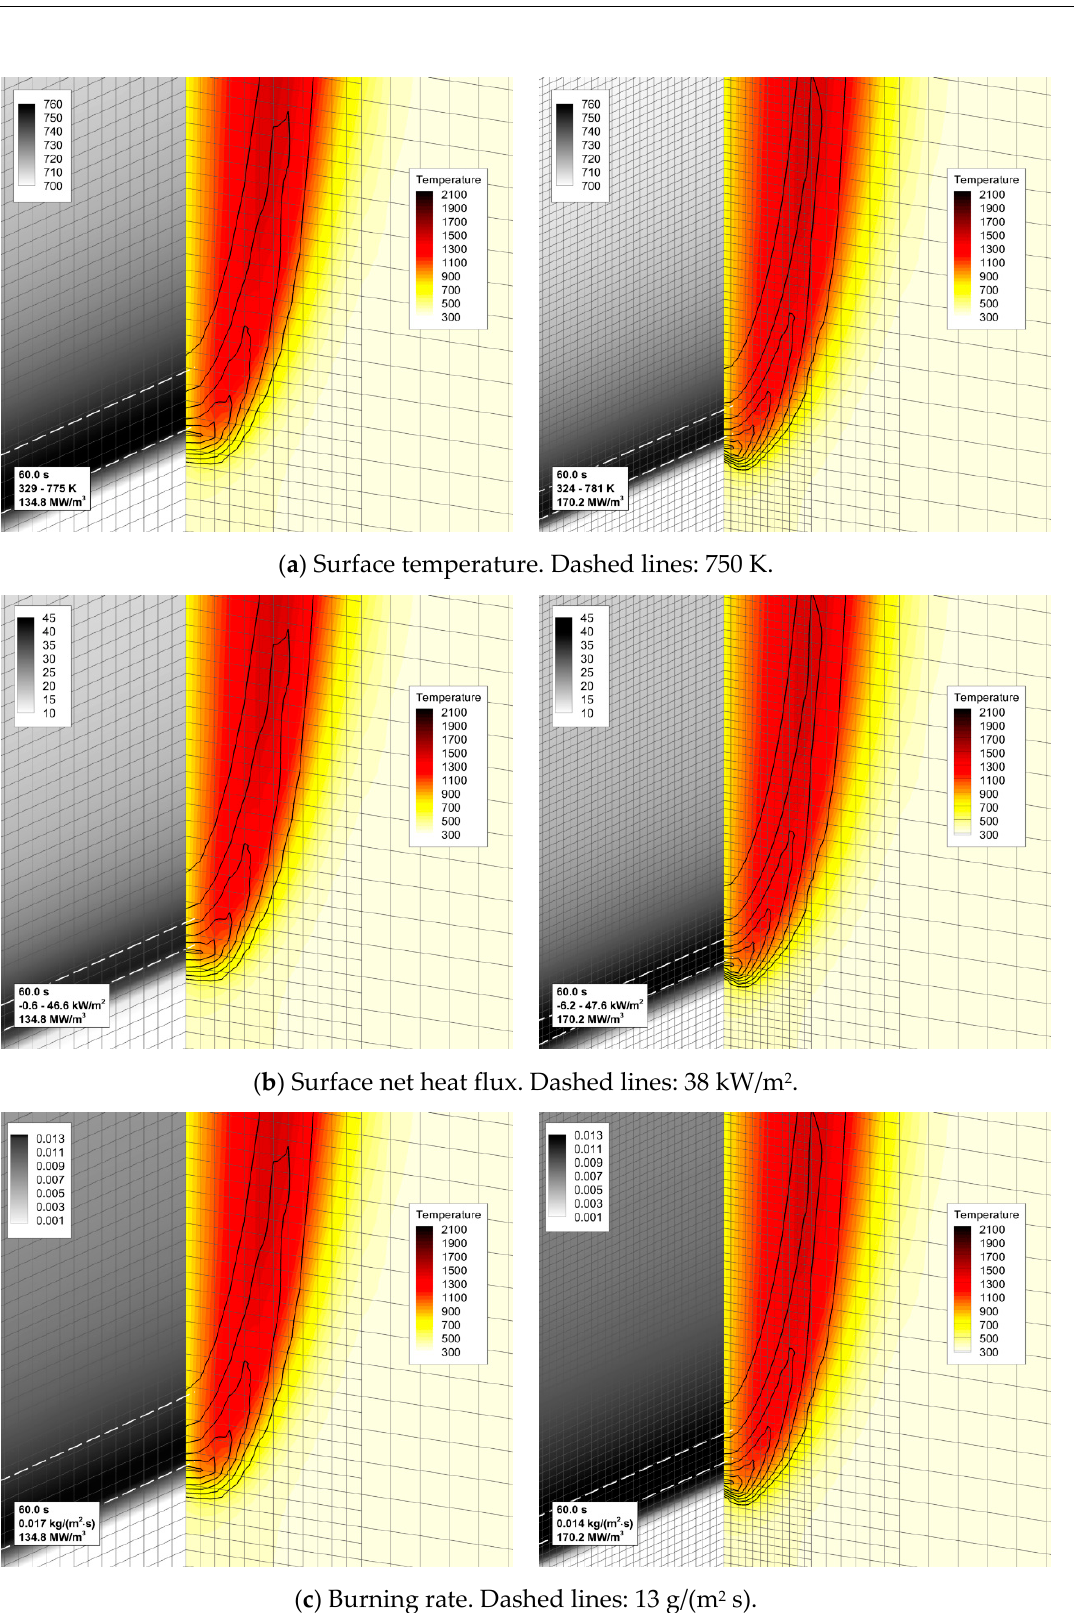
Figure 7. The effect of mesh refinement on flame structure and sample surface distributions near the edge of propagating flame. Distributions of ( a ) temperature, ( b ) net heat flux, and ( c ) volatile emission rate per unit area (burning rate) over the sample surface are shown along with the distributions of gas temperature (color) and volumetric heat release rate (lines) in the vertical plane containing the sample centerline. Left —mesh 2, right —mesh 3.